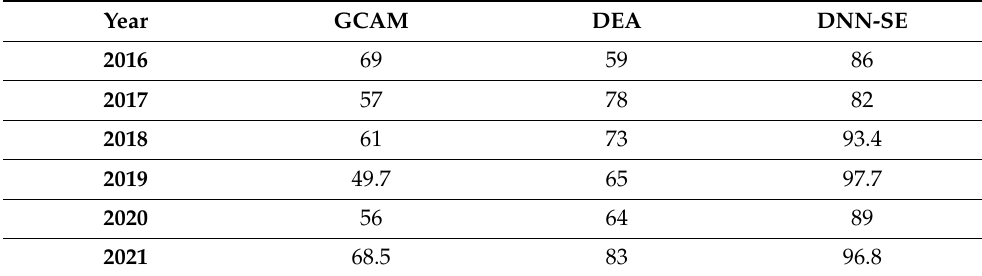
Table 1. The growth rate of energy consumption.